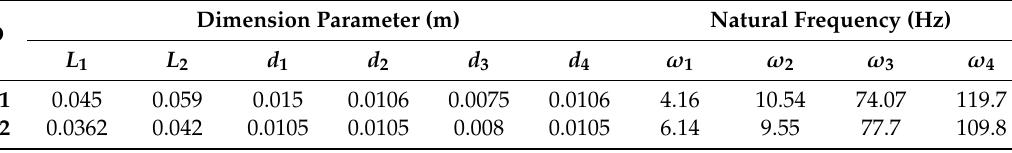
Table 5. Calculation results of 2DOFs TMDs.